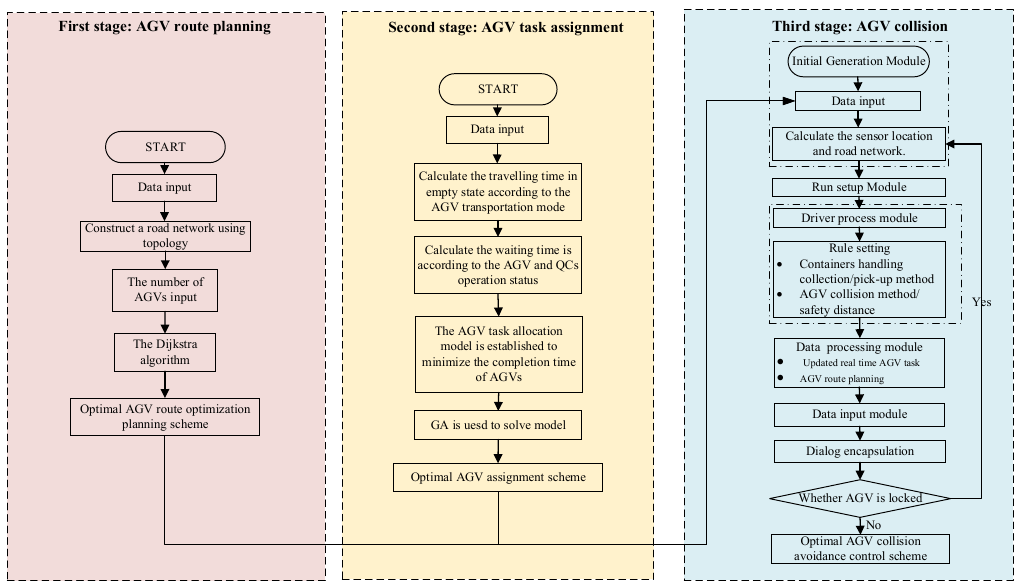
Figure 3. Flowchart of the methodology combining GA with simulation for the proposed three-stage optimization model.